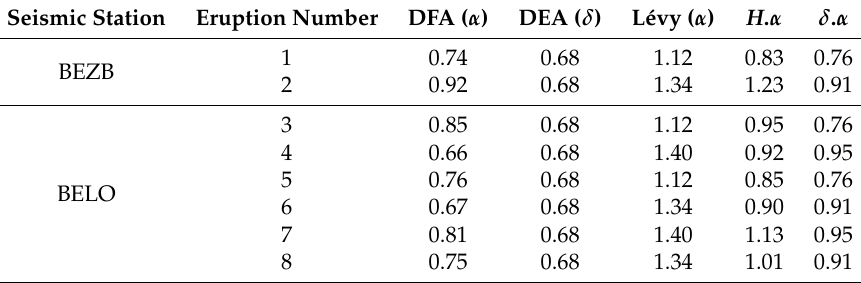
Table 4. Scaling exponents of Volcanic Data from the two seismic